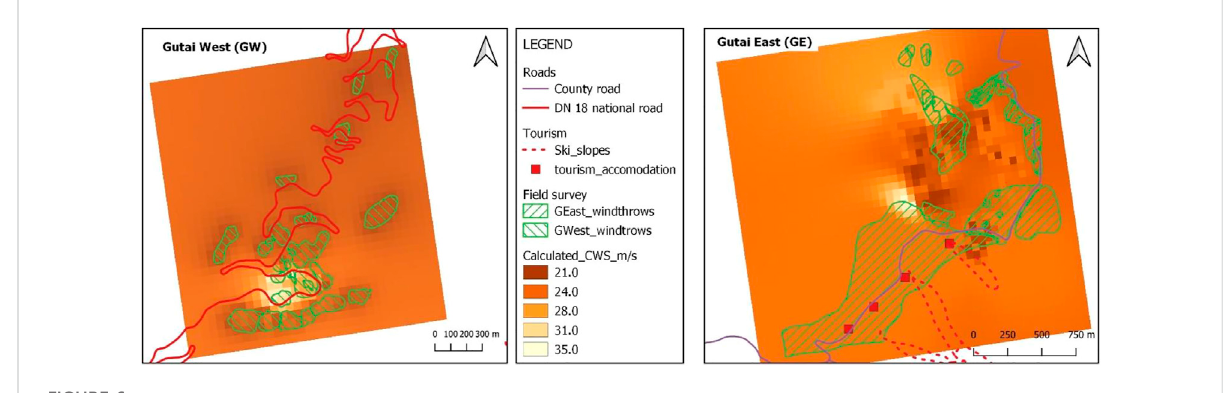
FIGURE 6 Calculated critical wind speed (CWS) m/s for the surveyed